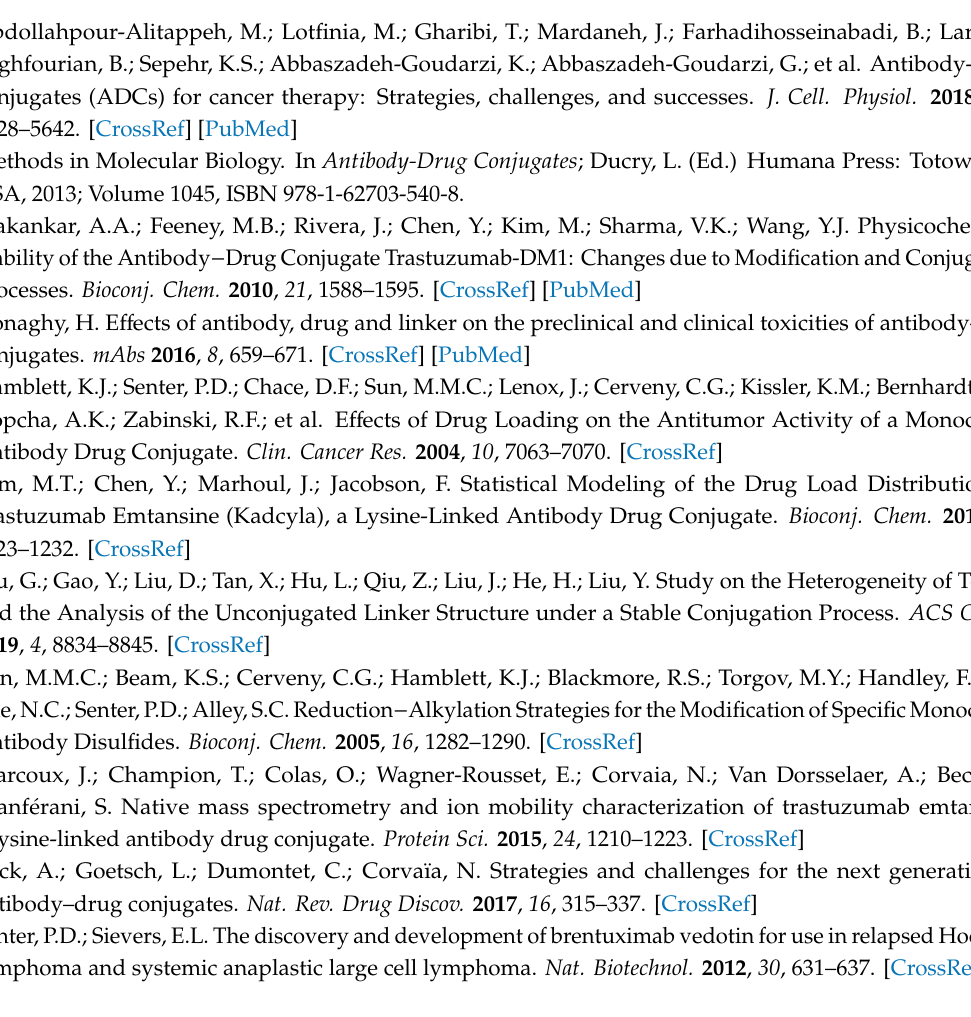
step) from samples desalted prior to the reduction step, for injecting the corresponding amount of sample into the RPLC–MS. Values are calculated taking the dilution of desalted samples for duplicate samples preparations, Table S2: Recovery of signal (compared to sample without desalting step) from samples desalted after the reduction step, for injecting the corresponding amount of sample into the RPLC–MS. Values are calculated taking the dilution of desalted samples for duplicate samples preparations, except for trastuzumab, Table S3: Recovery calculated from Bradford data for samples desalted before and after the reduction step, Table S4: Percentile changes in how large percentage of the total signal constituted of aggregate, monomer and fragment signal for trastuzumab after 7 or 41–44 days storage at two di ff erent temperatures, Table S5: Percentile changes in how large percentage of the total signal constituted of aggregate, monomer and fragment signal for DM1–trastuzumab ADC after 7 or 41–44 days storage at two di ff erent temperatures, Table S6: Percentile changes in how large percentage of the total signal constituted of aggregate, monomer and fragment signal for vcMMAE–trastuzumab ADC after 7 or 41–44 days storage at two di ff erent